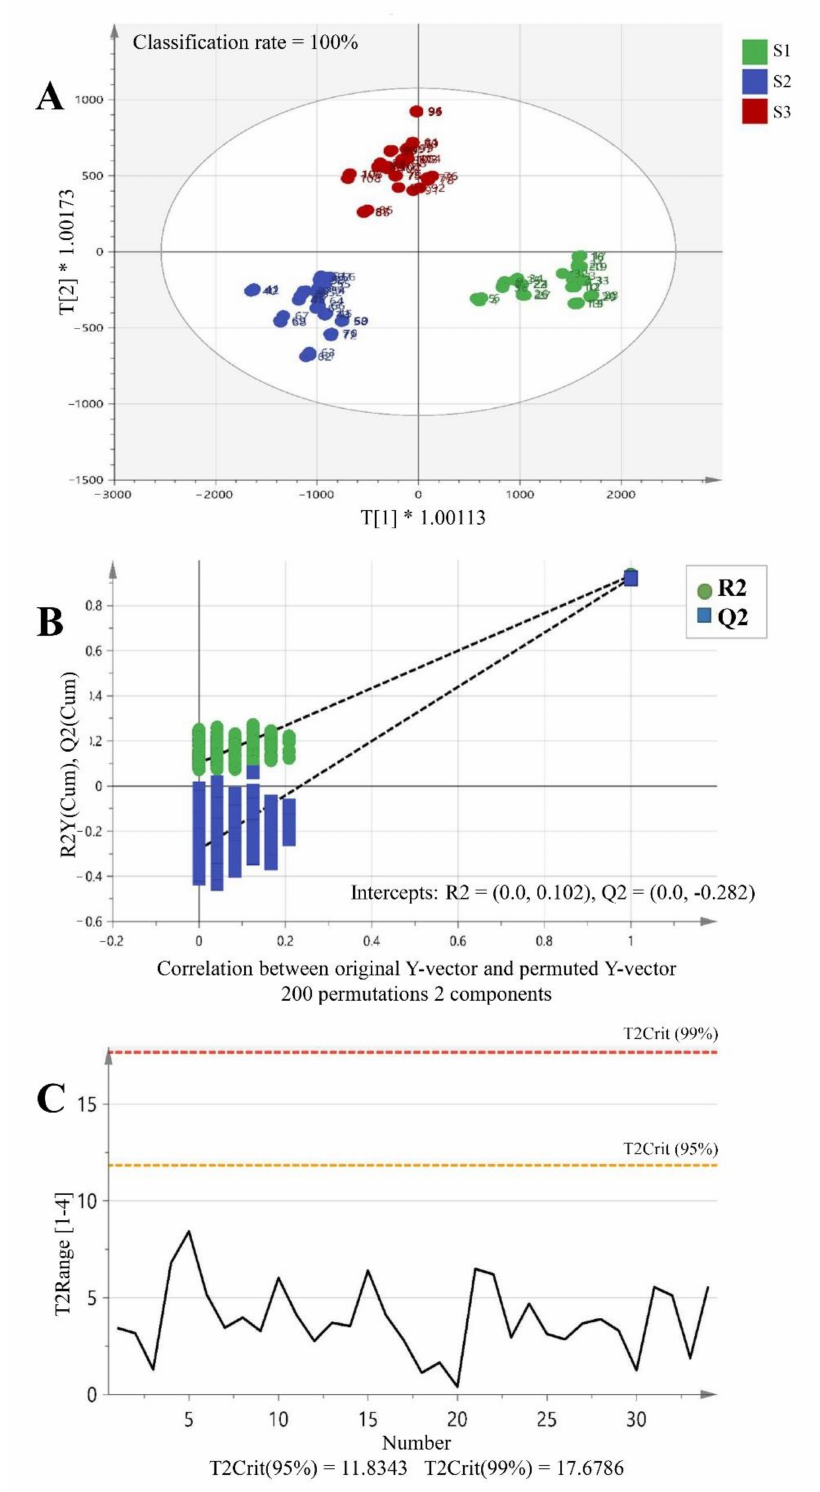
Figure 6. OPLS-DA score plot of samples from three stages (S1, S2, and S3) ( A ) and the validation of model using permutation test ( B ) and ( C ) Hotelling’s T 2 test ( R 2 X = 0.982, R 2 Y = 0.928, Q 2 Y = 0.901). T[1]*1.00113 and T[2]*1.00173 mean T[1] × 1.00113 and T[2] × 1.00173,